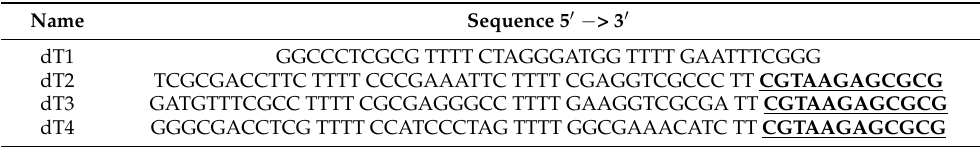
Table 1. DNA sequences for assembly of triangular nanoparticle. The underlined nucleotides correspond to sticky end regions complementary to the “Clicked”